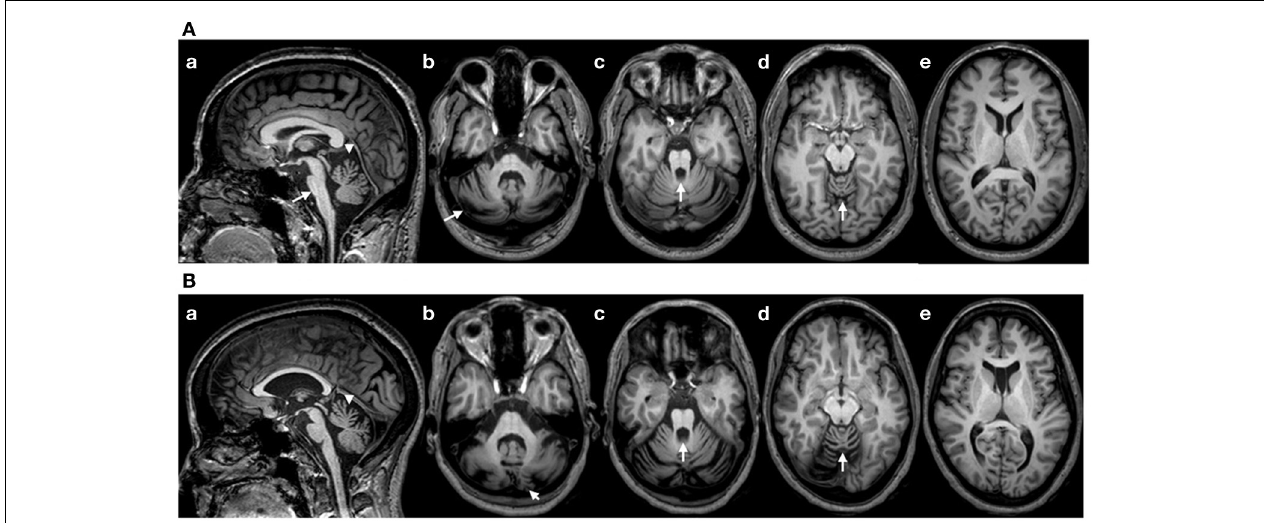
FIGURE 1 | (A) Brain MRI (T1-weighted images) in patient 1. (a): sagittal image showing a flattening of the pons (arrow), atrophy of the upper vermis (arrowhead) and a thin spinal cord in upper cervical segments; (b–d): axial sections showing atrophy of the cerebellum at the level of the middle cerebellar peduncle (b; arrow: atrophy of the cerebellar cortex), the upper pons with enlargement of the 4th ventricle (c; arrow)